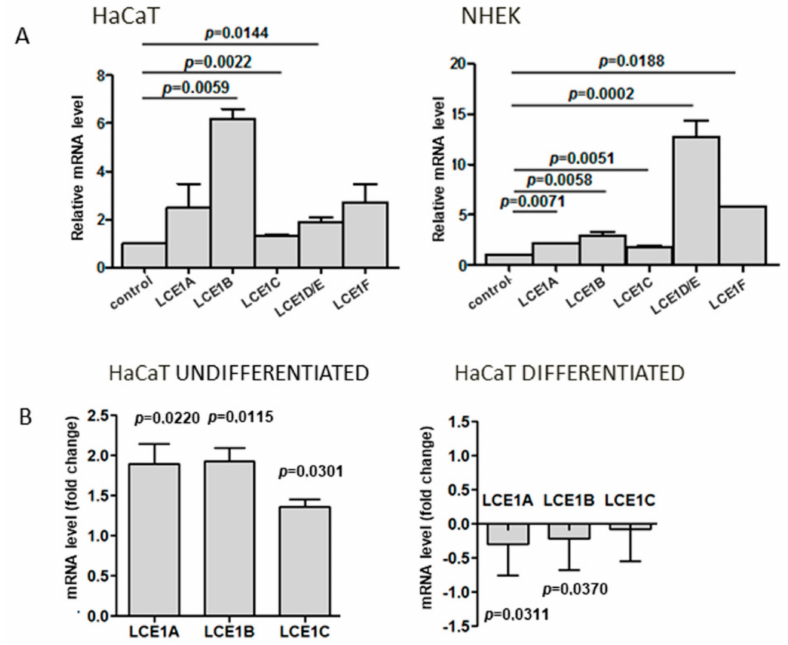
Figure 3. Expression of LCE1 genes. ( A ) Upregulation of LCE1A-F transcripts in di ff erentiated HaCaT cells (left panel) and primary human keratinocytes, NHEK (right panel), in comparison to undi ff erentiated cells (control). ( B ) Fold di ff erence in expression of LCE1A , LCE1B , and LCE1C in undi ff erentiated (left panel) and di ff erentiated (right panel) SUV39H1-KO HaCaT cells over WT HaCaT cells. The bars represent mean ± SEM calculated from the results of n = 3–5 (depending on the gene) RT-qPCR experiments. Each experiment consisted of three technical replicates and was performed on a di ff erent batch of RNA. Statistically significant di ff erences are indicated by horizontal bars and the respective p